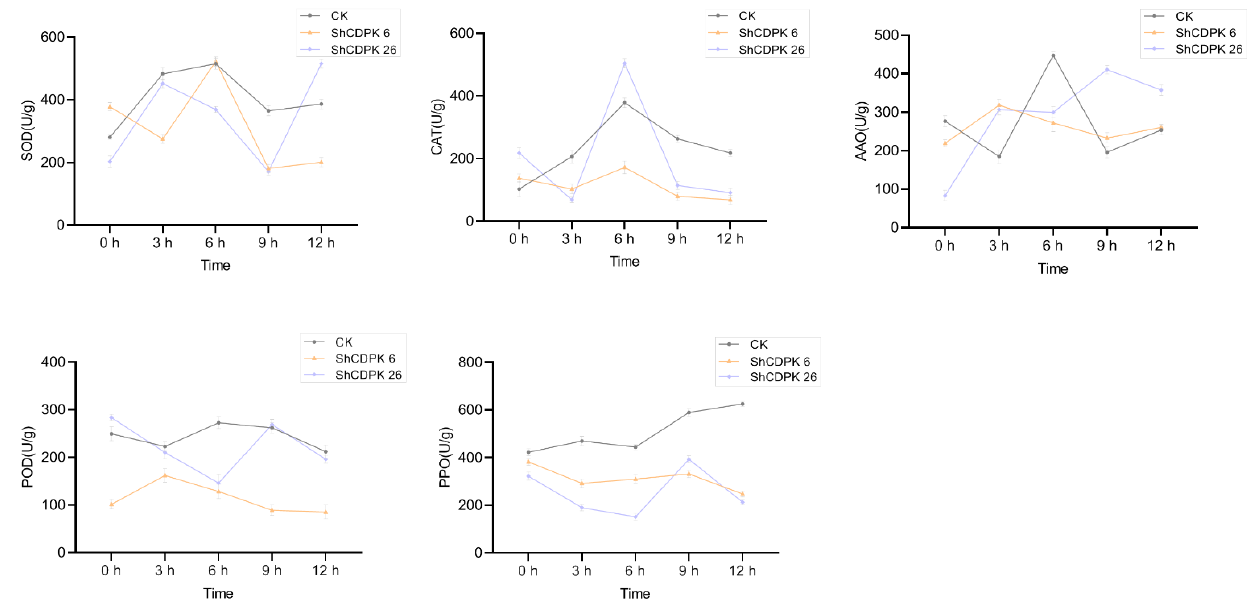
Figure 8. Determination of physiological indexes of ShCDPK6 and ShCDPK26 silenced plants and control plants under drought stress. Activity of SOD, CAT, AAO, POD, PPO. Each value is the mean ± standard deviation of at least three independent measurements.